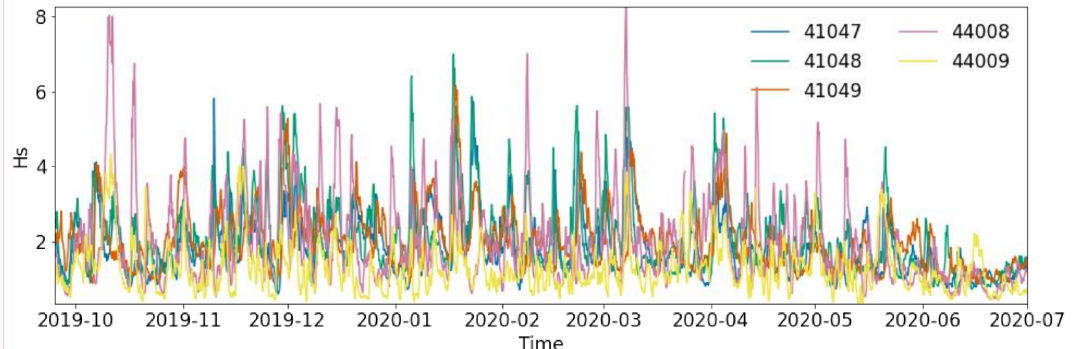
Figure 1. National Data Buoy Center (NDBC) buoys in the North Atlantic Ocean that were selected for the study.